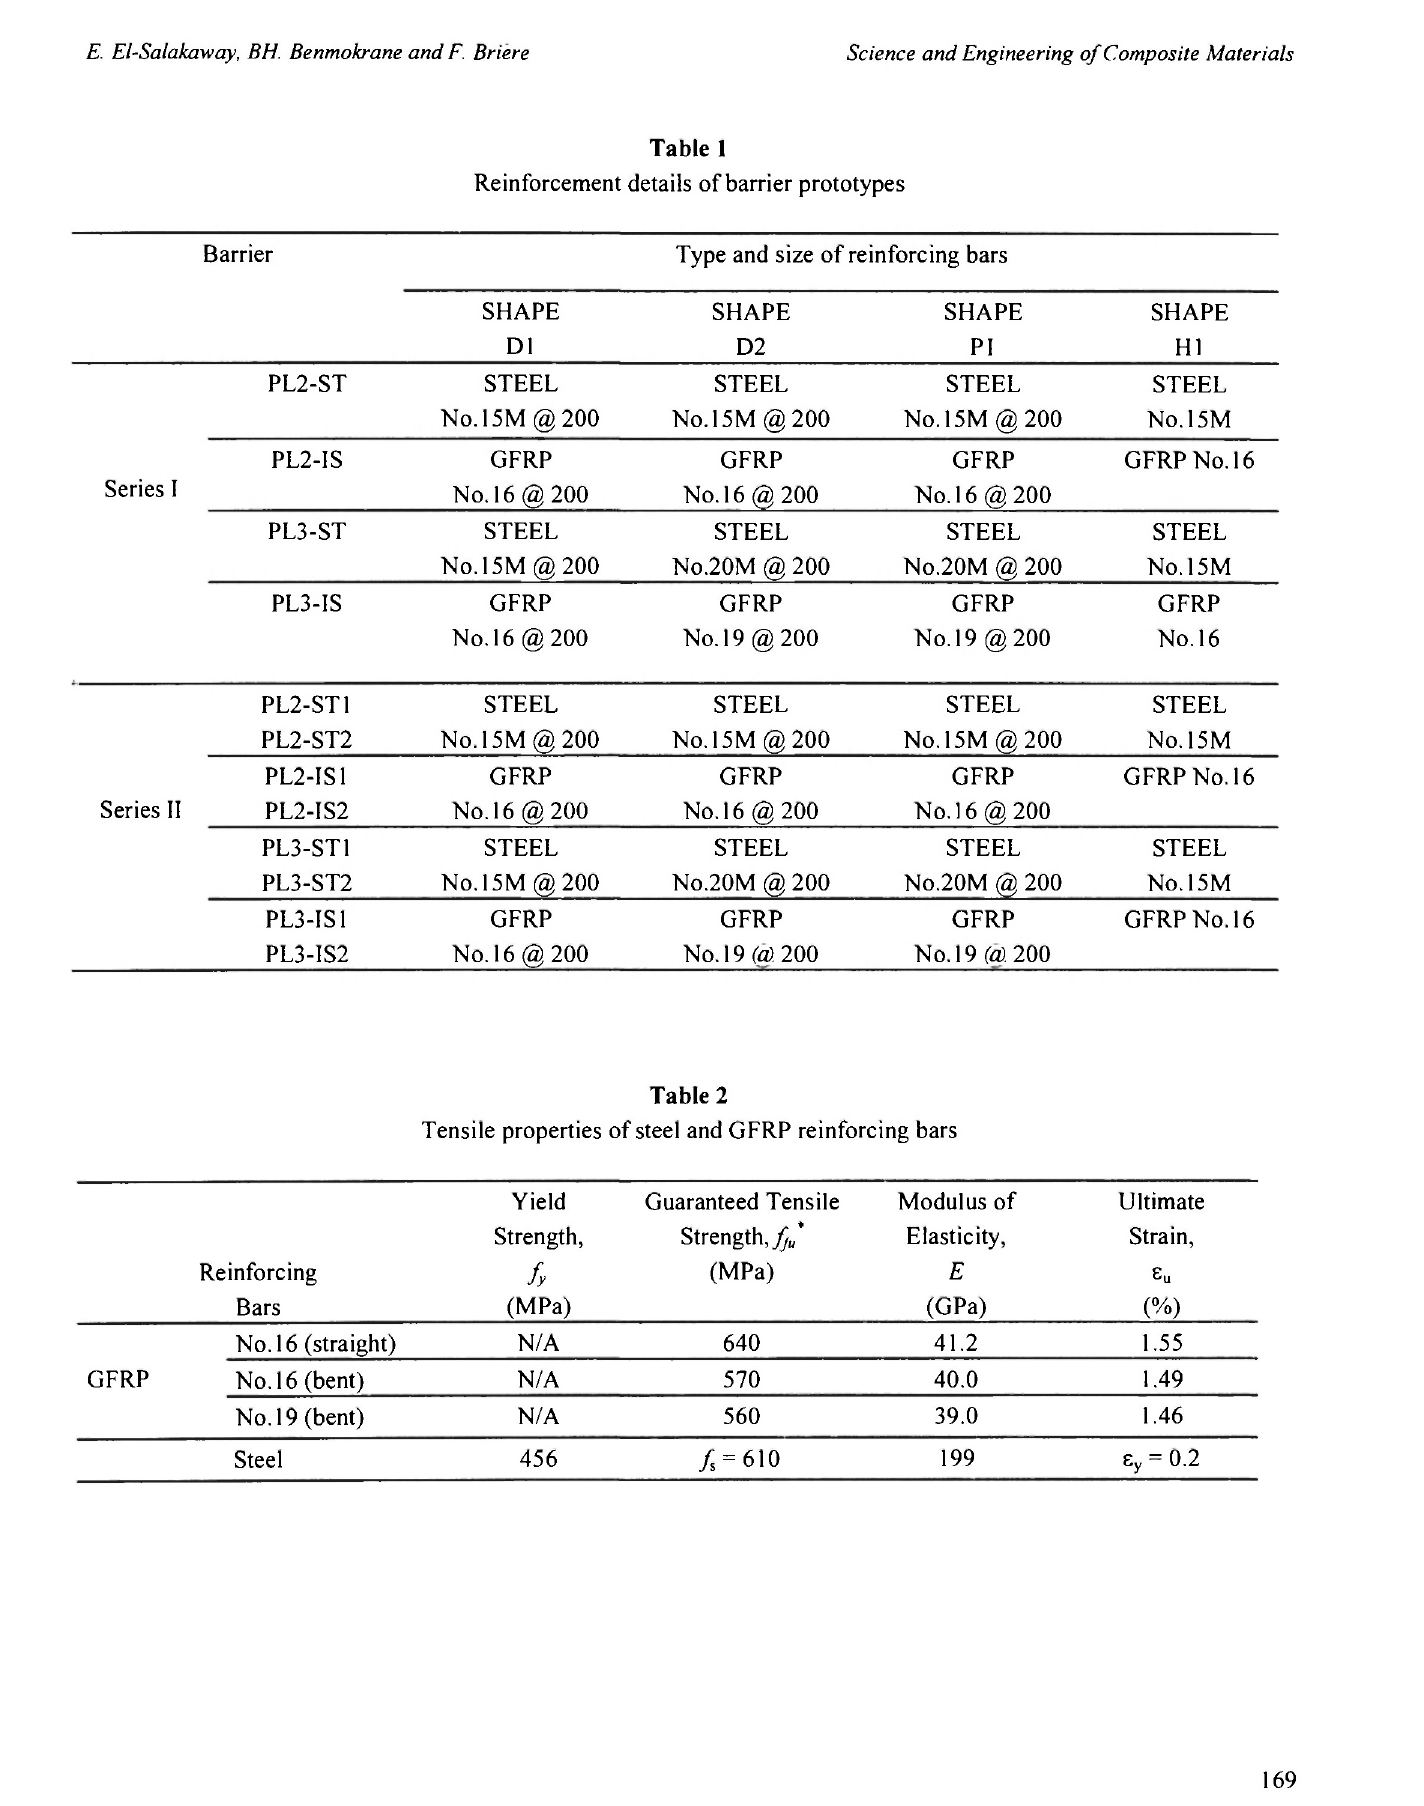
Reinforcement details of barrier prototypes